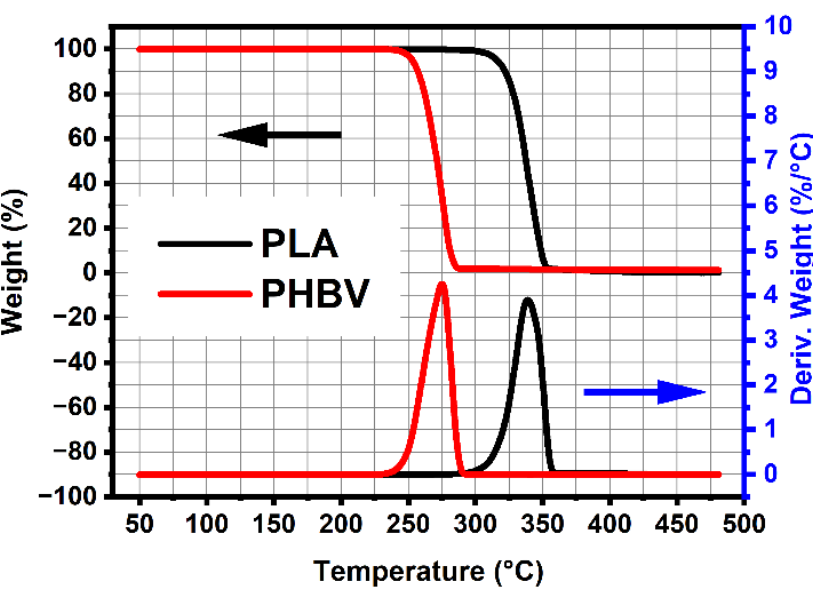
Figure 2. Results from TGA of pure PLA and PHBV.